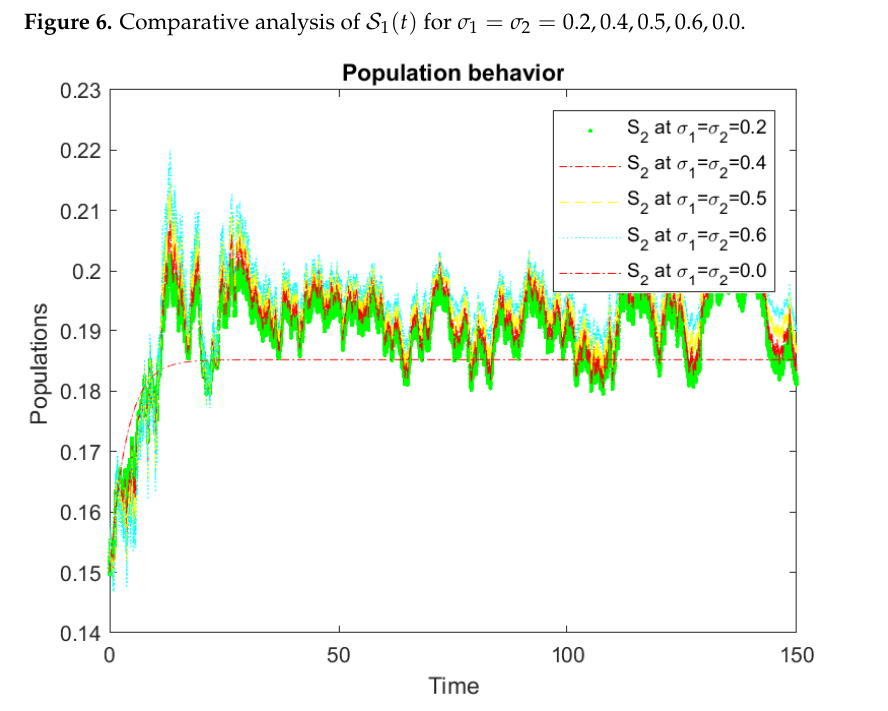
Figure 7. Comparative analysis of S 2 ( t ) for σ 1 = σ 2 =